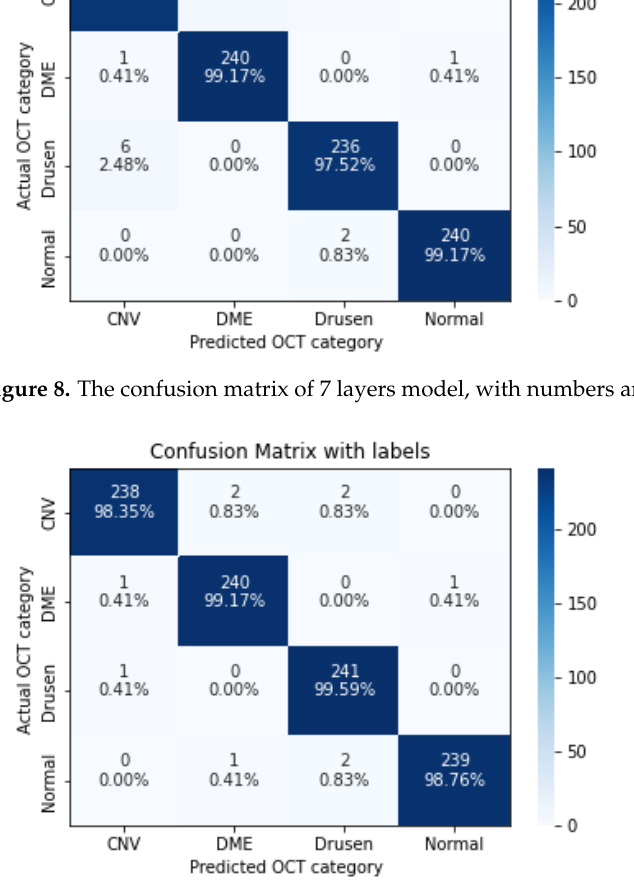
Figure 9. The confusion matrix of 9 layers model, with numbers and percentages.